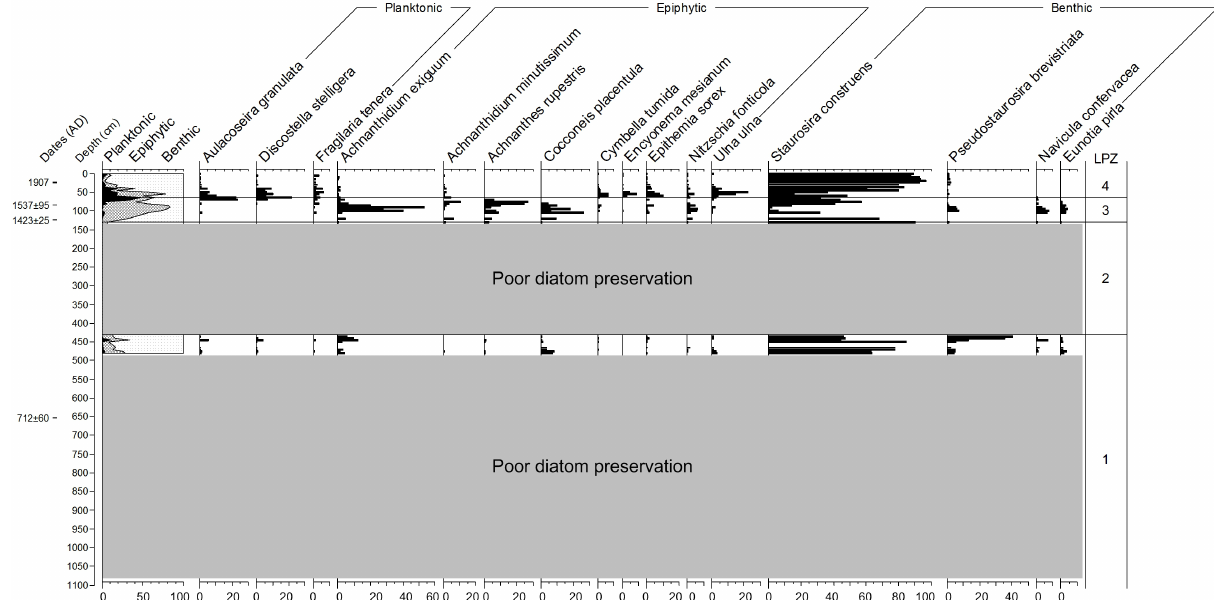
Figure 5. Sediment profiles of dominant planktonic, epiphytic, and benthic diatoms on the basis of pollen zones